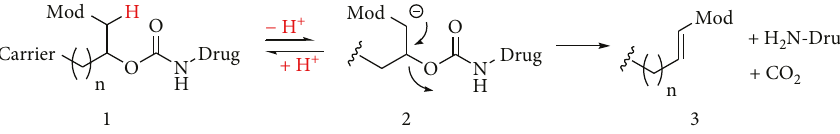
Figure 2: β -Elimination mechanism of linker